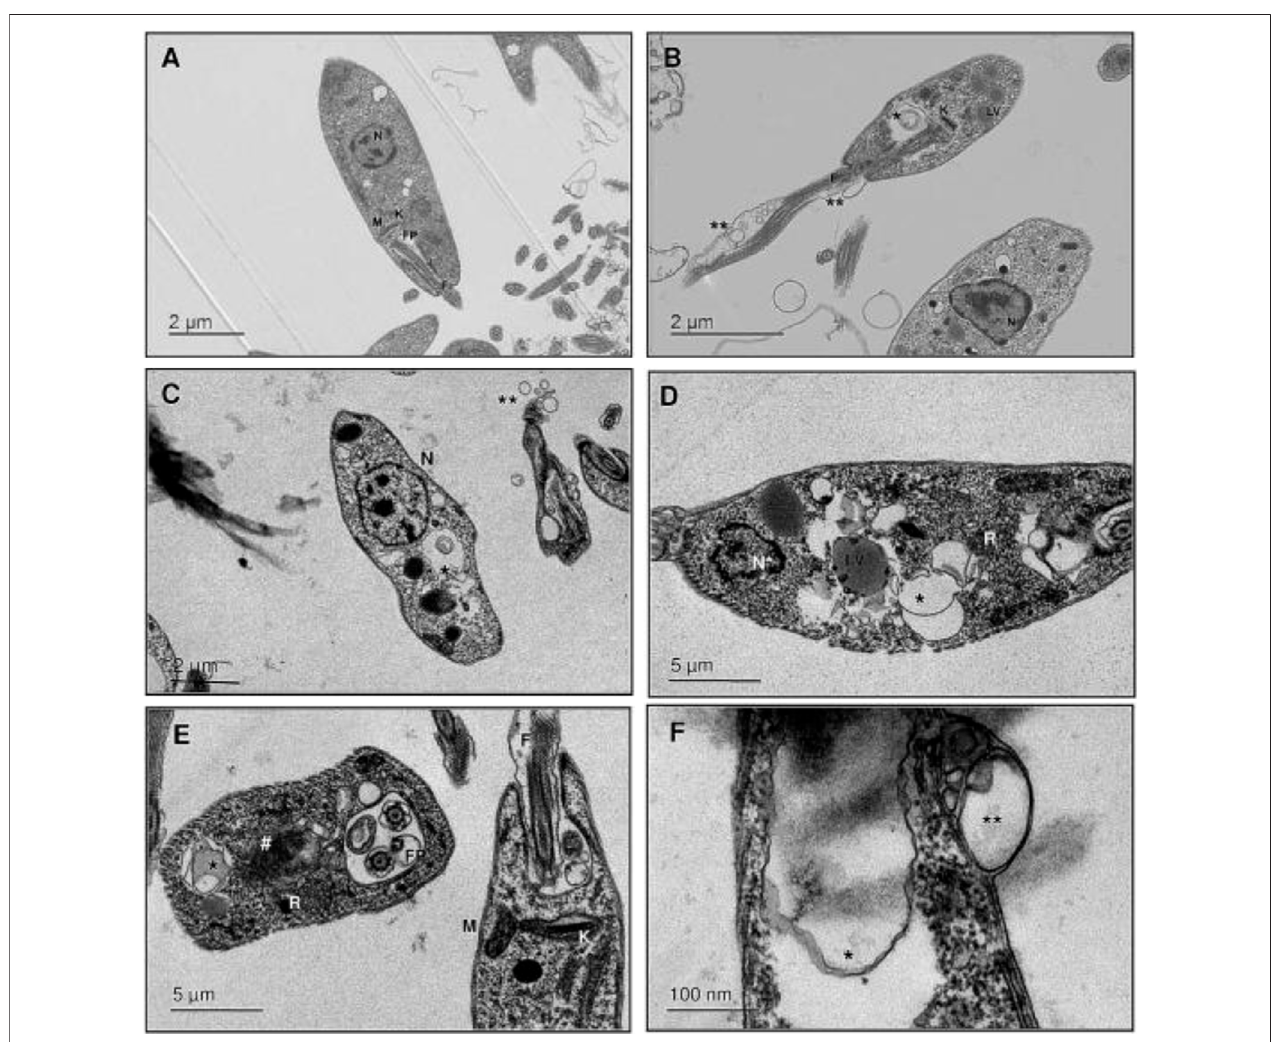
FIGURE 7 | Transmission electron microscopy of L. amazonensis treated with T. riparia essential oil (TrEO) for 24 h. (A) Leishmania promastigotes. (B – F) Promastigotes treated withTrEO (30 ng/ml). N, nucleus; N*, abnormalchromatin condensation nuclear alterations; K,kinetoplast; M, mitochondria;FP, fl agellar pocket; F, fl agellum; V, vacuoles; LV, lipid vesicles; R, myelin-like fi gure appears in close association with the fl agellar pocket membrane; *membranous pro fi les; **blebbing; # mitochondrial swelling (Adopted from Demarchi et al., 2015 2 ).